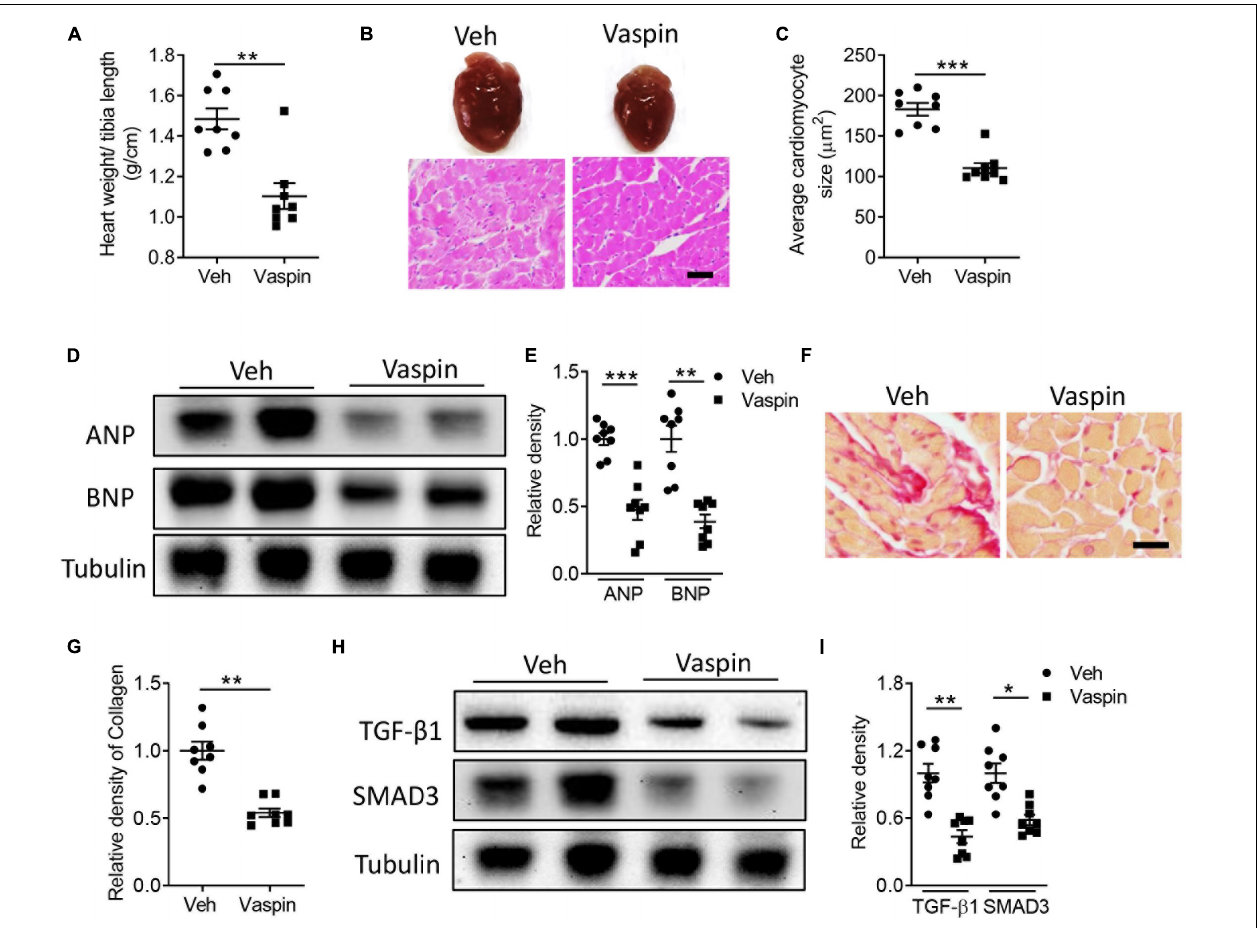
FIGURE 2 | Administration of recombinant vaspin protein attenuates cardiac hypertrophy and fibrosis in A-ZIP/F-1 lipoatrophic mice. Sixteen-week-old A-ZIP/F-1 mice were treated with recombinant vaspin protein (100 µ g/mouse) by an osmatic pump for 8 weeks. (A) The ratio of heart weight/tibia length. (B,C) Representative images of whole hearts, and cardiac slides were stained with hematoxylin and eosin solution (B) , and quantitative analysis of average cardiomyocyte size (C) . Scale bar = 20 µ m. (D,E) Western blot analysis of cardiac atrial natriuretic peptide (ANP) and B-type natriuretic peptide (BNP) (D) , and quantitative analysis of relative density of ANP/tubulin and BNP/tubulin (E) . (F,G) . Cardiac slides were stained with Sirius red solution (F) and quantitative analysis of relative density of collagen (G) . Scale bar = 40 µ m. (H,I) Western blot analysis of cardiac TGF- β 1 and SMAD3 (H) and quantitative analysis of relative density of TGF- β 1/tubulin and SMAD3/tubulin (I) . Results are shown as mean ± SEM, and n = 8 mice/group. * p < 0.05, ** p < 0.01, *** p <